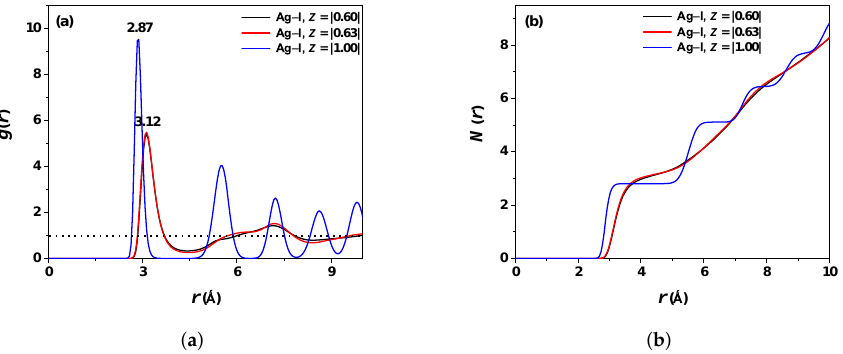
Figure 3. ( a ) PDF (Ag-I) with Z Ag,I = | 0.60 | (black line), Z Ag,I = | 0.63 | (red line), and Z Ag,I = | 1.00 | (blue line). ( b ) Integrated PDF ( N Ag-I ). Temperature 300